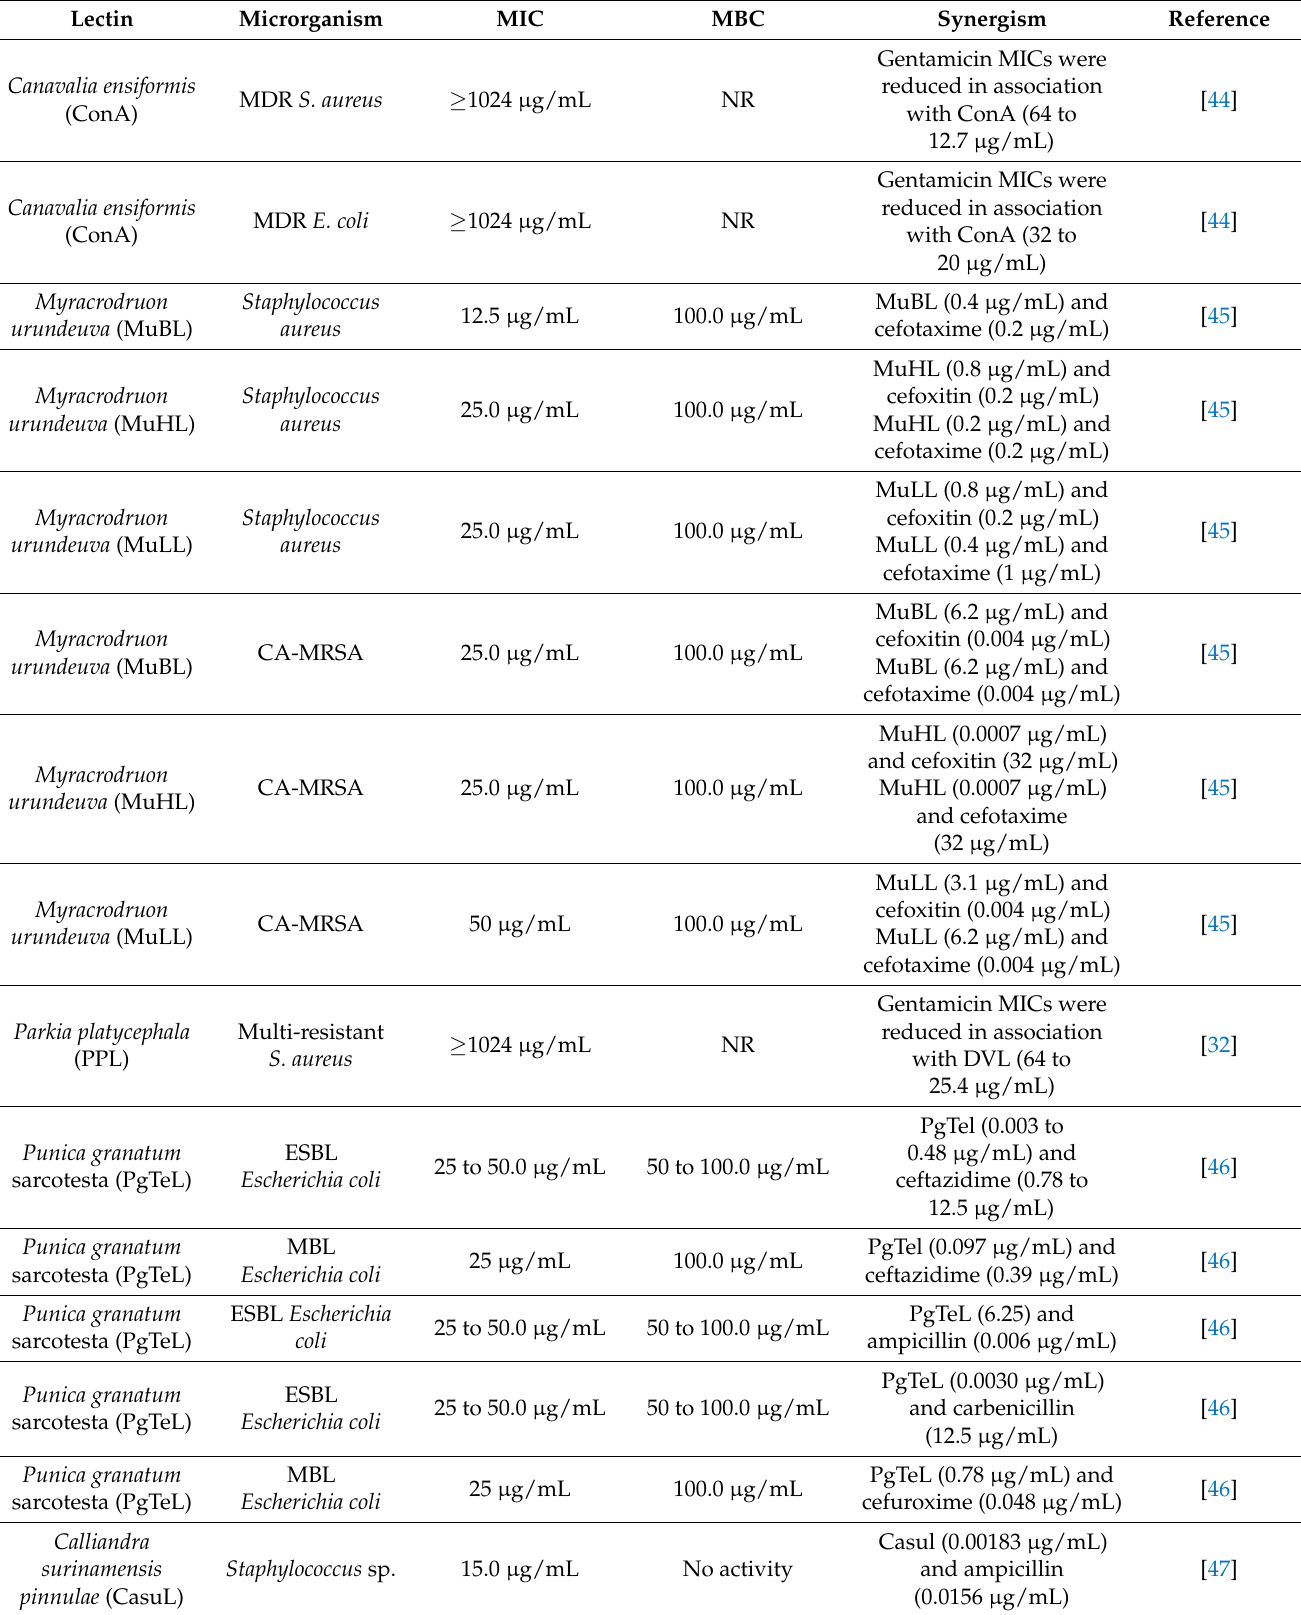
Table 2. Antimicrobial activity of lectins alone and in combination with